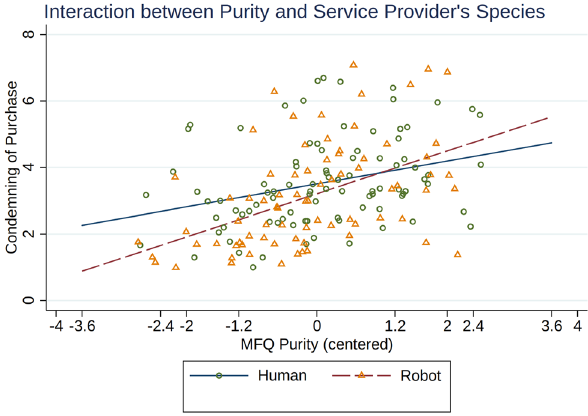
Figure 2: Interaction between MFQ purity/sanctity and species of service provider on condemning of purchase ( DV2 ) in the pilot